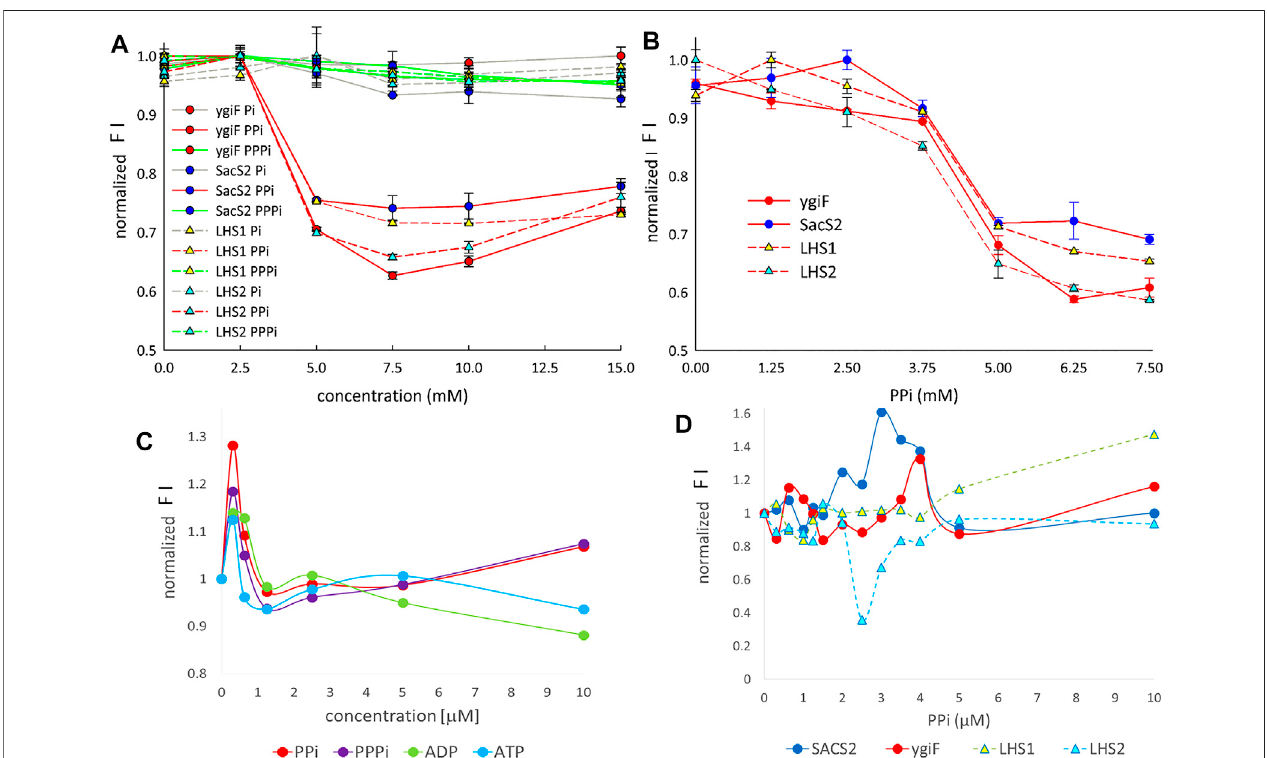
FIGURE 4 | The detection of (poly)-phosphates. (A) The in fl uence of Pi/PPi/PPPi on the relative fl uorescence intensity in the range from 0 to 15 mM and in the presence of 20 mM Mg 2+ (measured at 30 min after mixing phosphates with magnesium and consequent mixing with GFP-IBs). (B) Calibration in the presence of 20 mM Mg 2+ ,which mimicked PPi (7.5 mM)hydrolysisto 2Pi(15 mM). (C) In fl uence of PPi/PPPi and ADP/ATP on theSACS2 FI inthe range from 0 to10 µM and in the presence of 1.5 mM Pi but without Me 2+ ion. (D) In fl uence of PPi on the FI in the range from 0 to 10 µM and in the presence of 1.0 mM Mg 2+ , 1.4 mM Ca 2+ , and 1.5 mM Pi. For c and d, the results were obtained from the exact emission maxima (506 – 512 nm) from spectral scans. FI means the fl uorescence